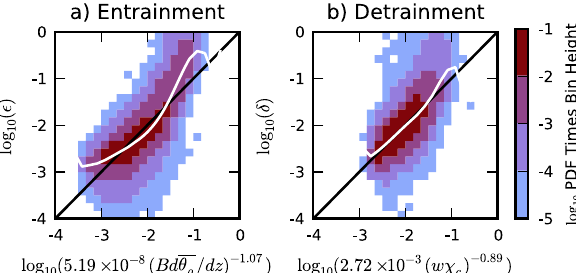
Fig. 14. Joint probability density functions multiplied by bin area ( P(x,y)1x1y ) for the horizontal mean cloud ensembles of the BOMEX and ARM LES output between fractional mass entrain- ment/detrainment rates and best-fit entrainment/detrainment rates as predicted by cloud core properties. (a) log 10 ((cid:15)) versus the best-fit (cid:15)(B, d θ ρ / d z) relationship. (b) log 10 (δ) versus the best-fit δ(w,χ c ) relationship. PDFs are plotted using a logarithmic scale. White lines indicate the mean log 10 ((cid:15)) or log 10 (δ) values as functions of the best-fit relationship, and black lines show the log 10 ((cid:15)) or log 10 (δ) values predicted by the best-fit